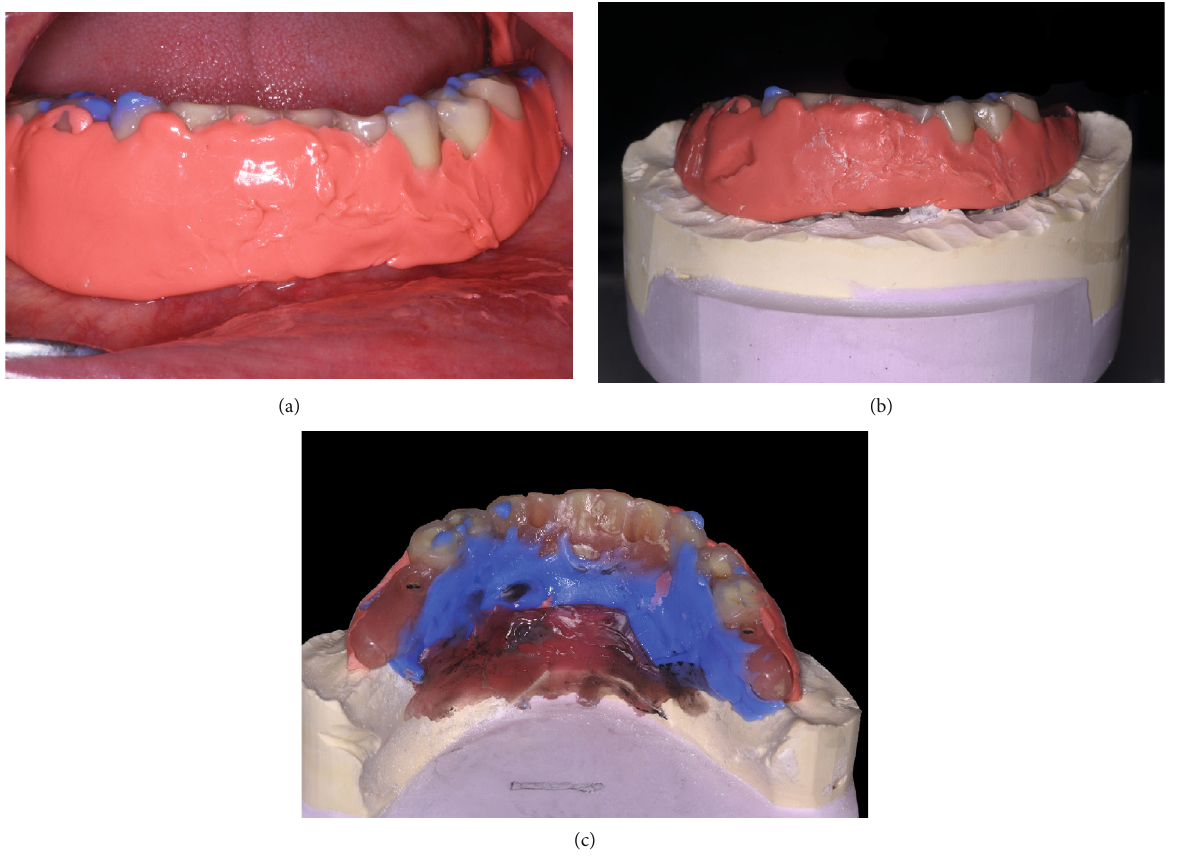
Figure 5: Posthealing prosthetic transformation. (a) Silicone impression material was injected under the prosthesis to fi ll the space, and occlusion was registered. (b) After the preparation of the model, the complex prosthesis and silicone are screwed onto the master cast model. (c) The restoration was boxed in the lingual area on the modi fi ed cast